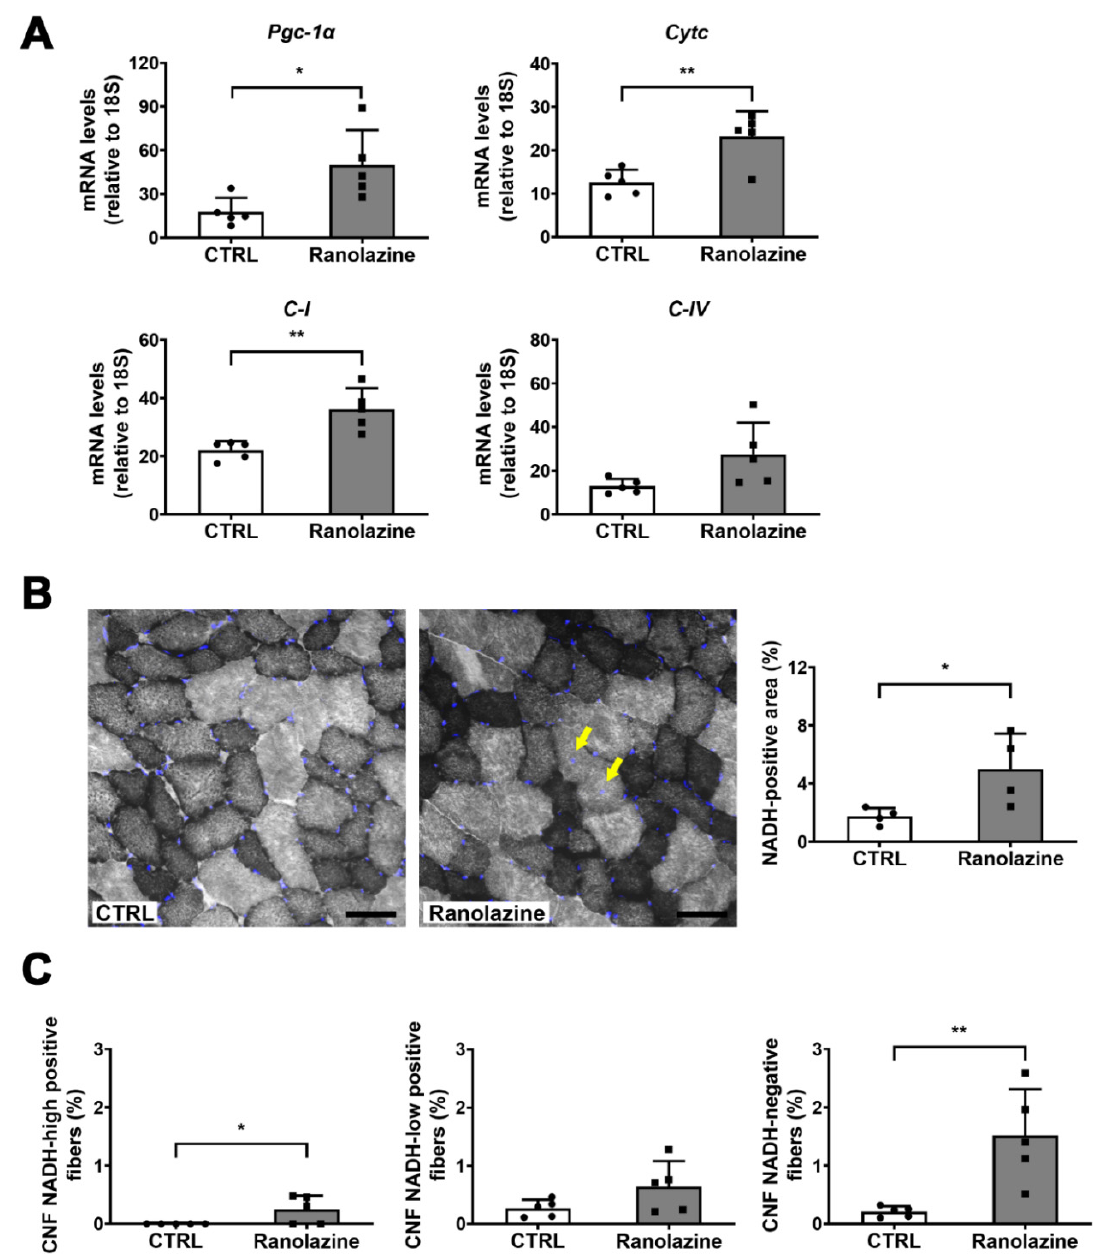
Figure 3. Up-regulation of mitochondrial genes and increase in NADH-dehydrogenase upon Ranolazine treatment. ( A ) qPCR expression analysis of key mitochondrial genes on whole TA muscle lysates of untreated (CTRL) and Ranolazine-treated mice. All data are reported as relative to the housekeeping gene 18S. Values are means ± SD. N = 5 for both experimental conditions. ( B ) Representative images of NADH-TR staining in cross-sections of TA muscle of 24-month-old mice treated with Ranolazine or not (CTRL). Nuclei were counterstained with DAPI (blue). Yellow arrows point at CNF. The histogram shows the percentage of the NADH-TR positive area of whole TA section. Scale bar = 50 µm. Values are means ± SD. n = 4 for both experimental conditions. ( C ) Percentage of CNF NADH-TR-high positive, CNF NADH-TR-low positive and CNF NADH-TR-negative fibers. Values are means ± SD. n = 5 for both experimental conditions. Unpaired t -test was used for comparison. ** = p < 0.01, * = p <